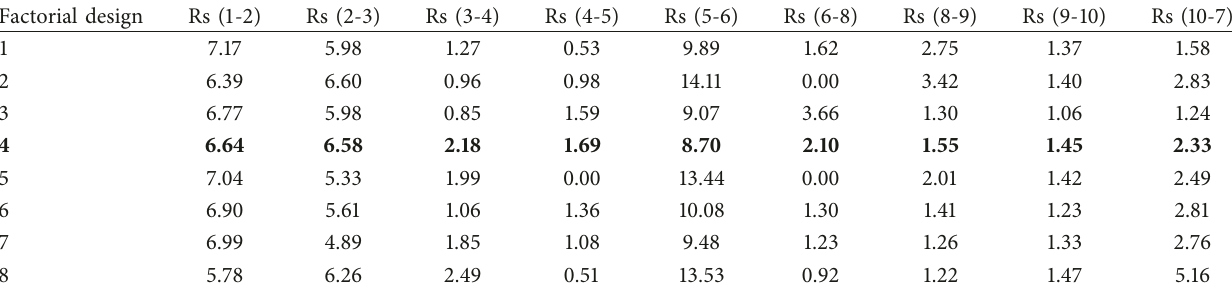
Table 2: Chromatographic resolutions obtained in the factorial design.